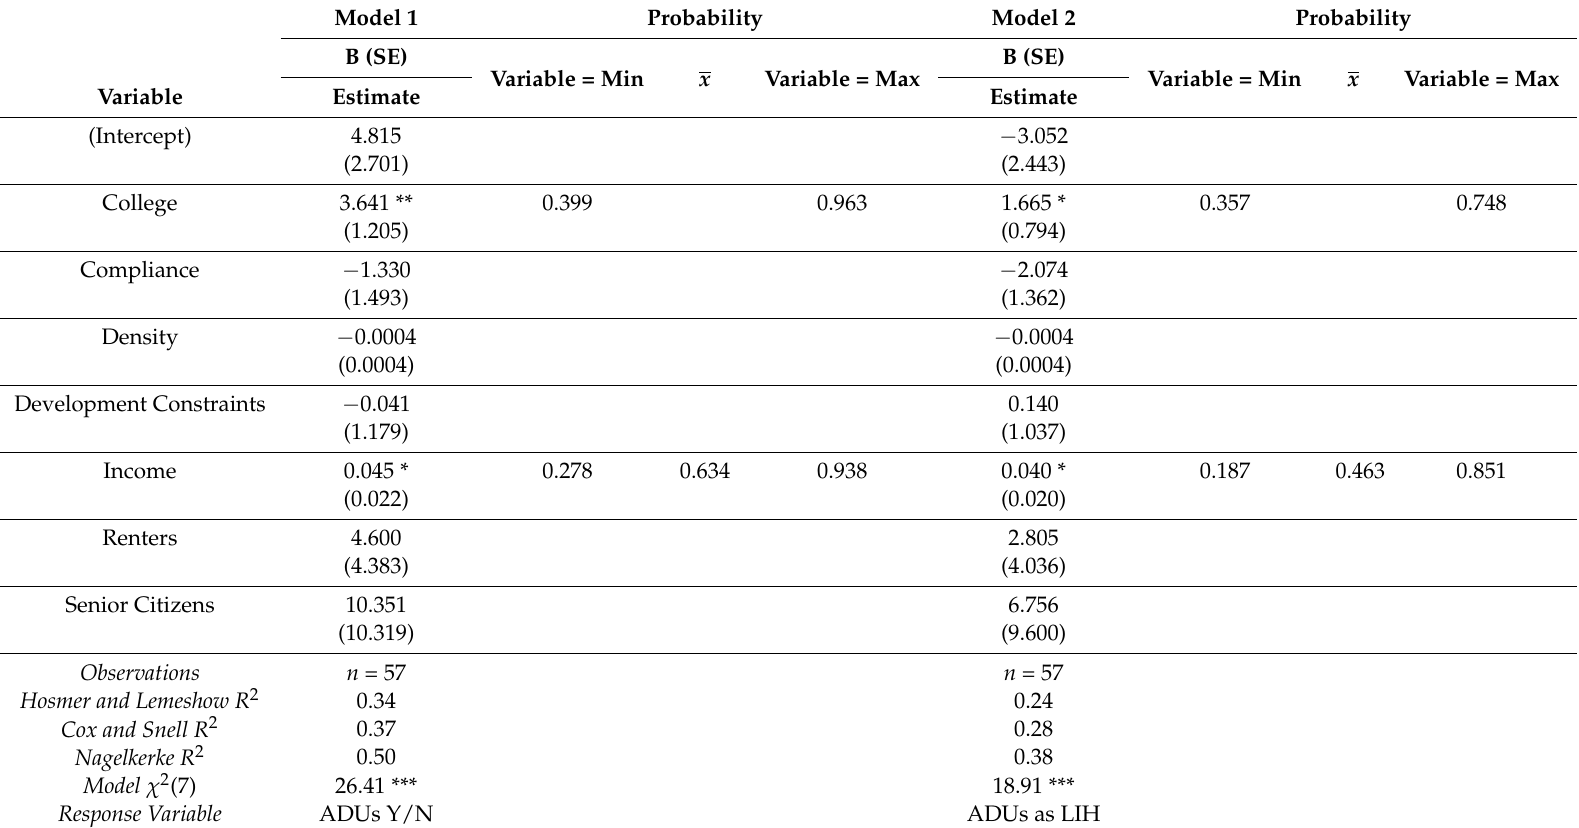
Table 8. The logistic regression models. In Model 1, cities with colleges were 96% more probable to count potential ADUs overall. In addition, cities with household incomes close to the mean ($68,670) were 63% more probable to count potential ADUs overall. In Model 2, cities with a college were 75% more probable to count potential ADUs towards low-income housing needs than non-college cities. In addition, cities with household incomes close to the maximum value ($116,547) were 85% more probable to count potential ADUs towards low-income housing needs. Notes: ADU = accessory dwelling unit, LIH = low-income housing, SE = standard error, Y/N = yes or no; * = p < 0.05, ** = p < 0.01, *** = p <